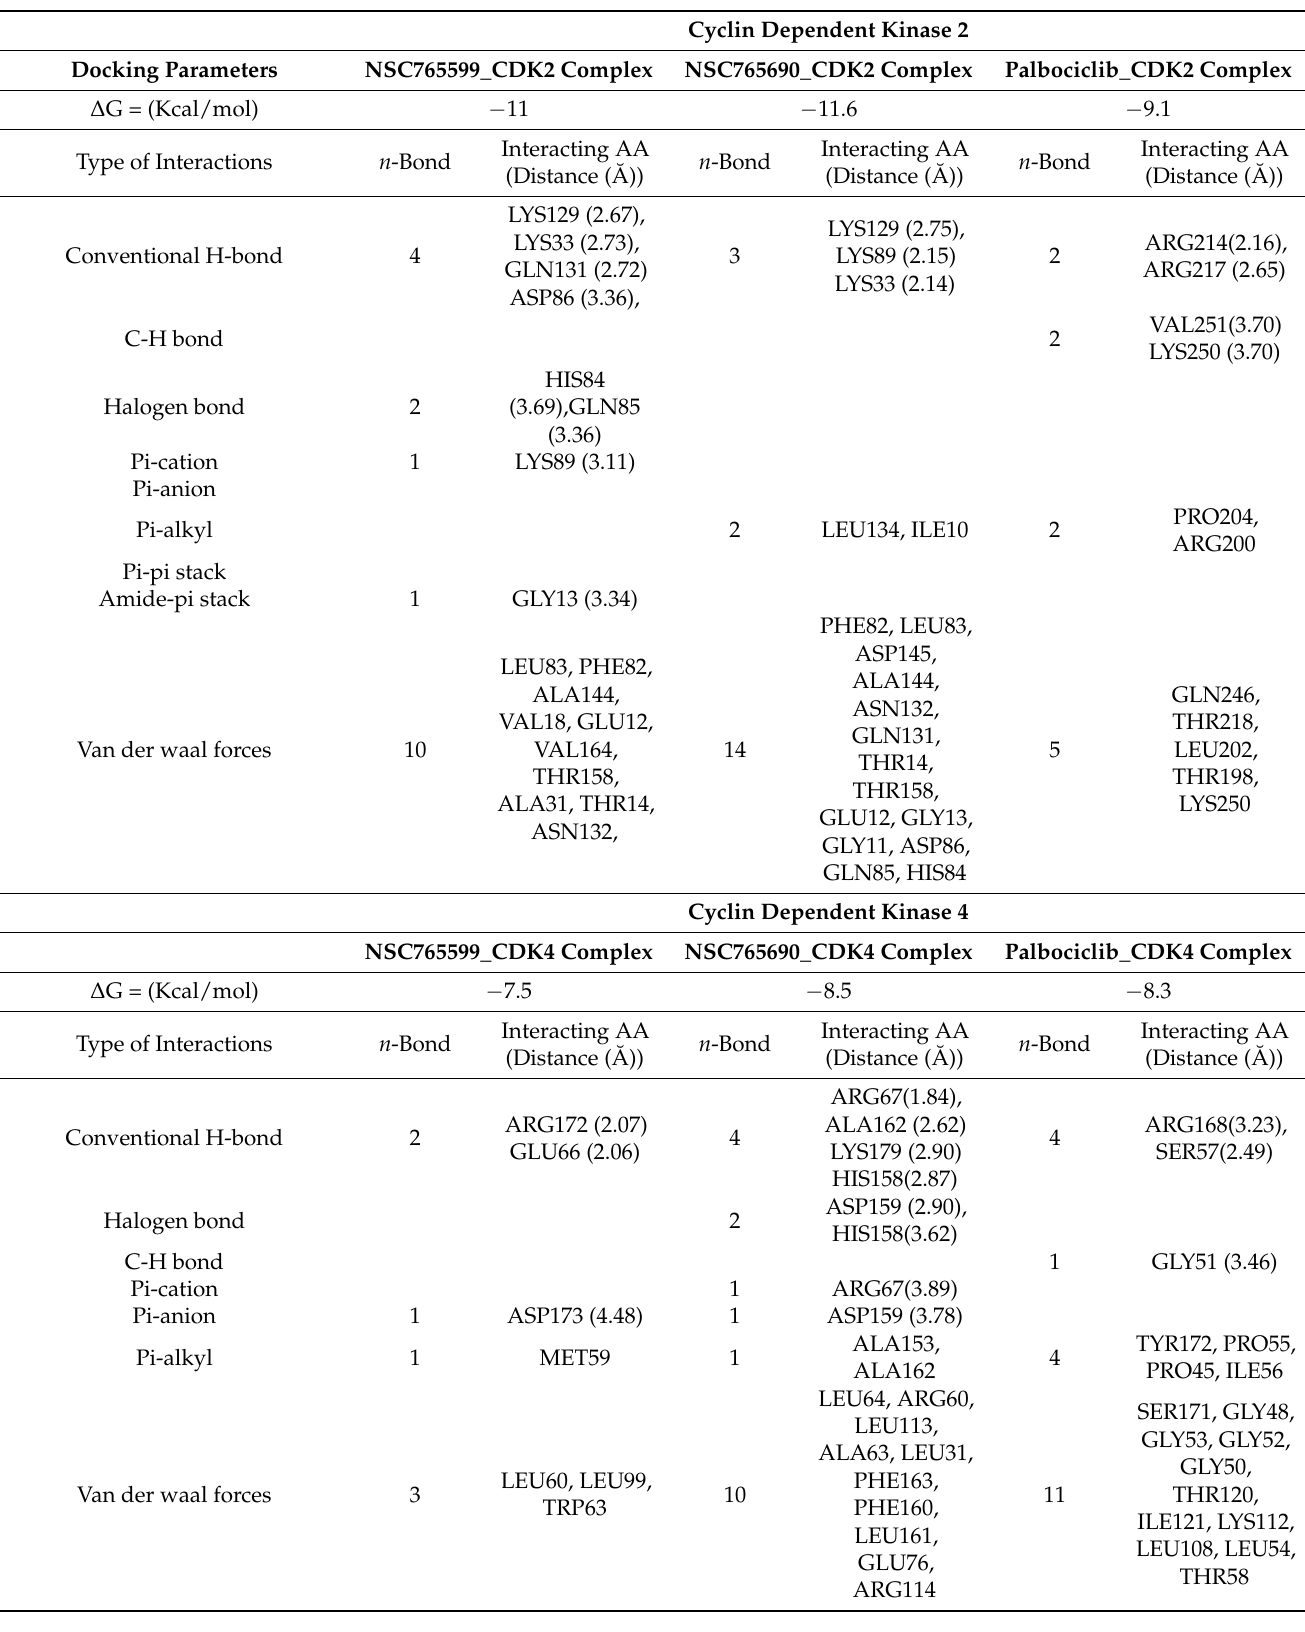
Table 6. Comparative docking profile of NSC765690, NSC765599 and standard STAT3/CDK2/4/6